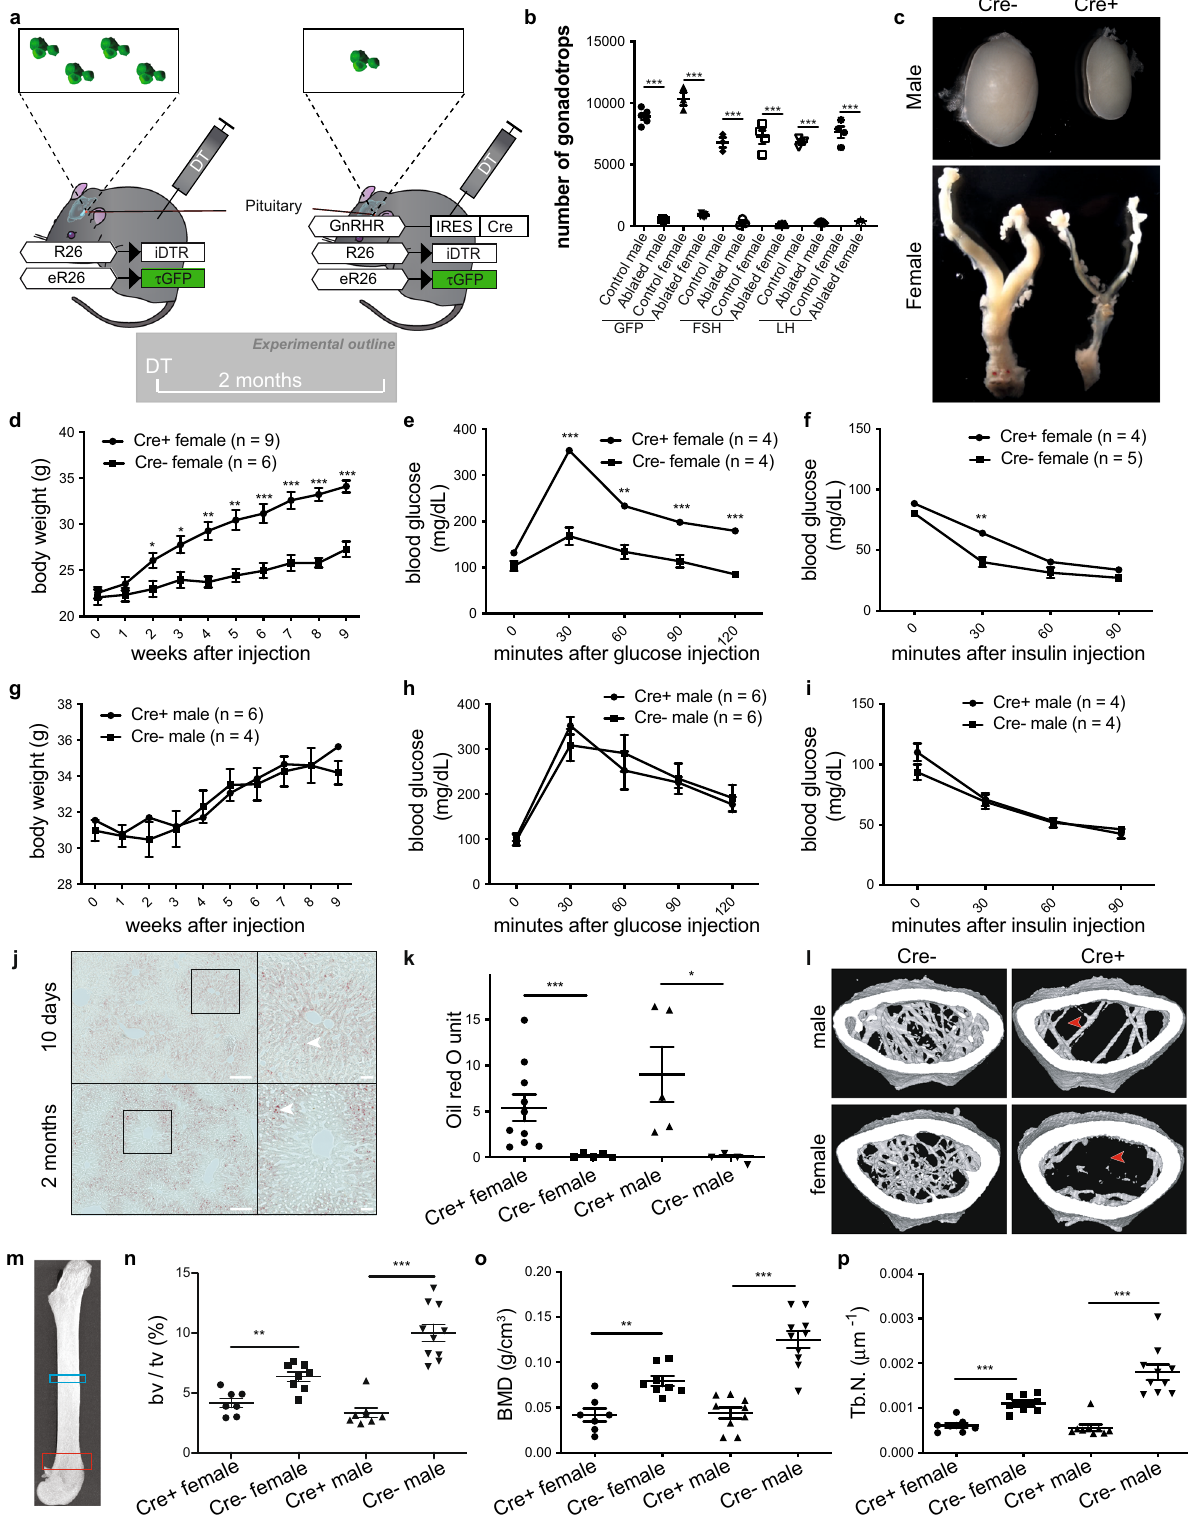
Fig. 10e – l) in these cells. Sex steroid replacement also prevented hepatic steatosis in males but had no effect in females (Fig. 3g, h). These data demonstrate that the majority of cardinal features of metabolicsyndromecanbeprecipitatedbytheabsenceofgonadalsex steroids; however, uniquely in females, liver steatosis appears to depend on the loss of